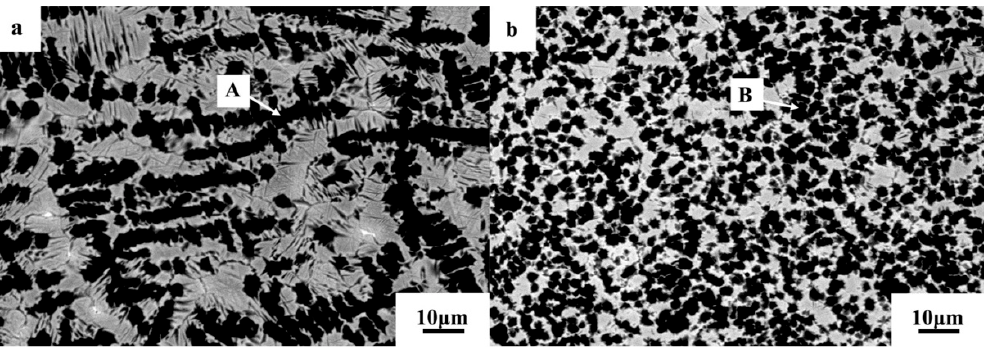
Figure 3. Backscattered electron micrograph of the coating of 30ZrN at different locations; ( a ) at the top of the coating and ( b ) at the bottom of the coating. Table 1. Electron probe micro-analyzer (EPMA) analysis of different position components of the coating of 30ZrN.